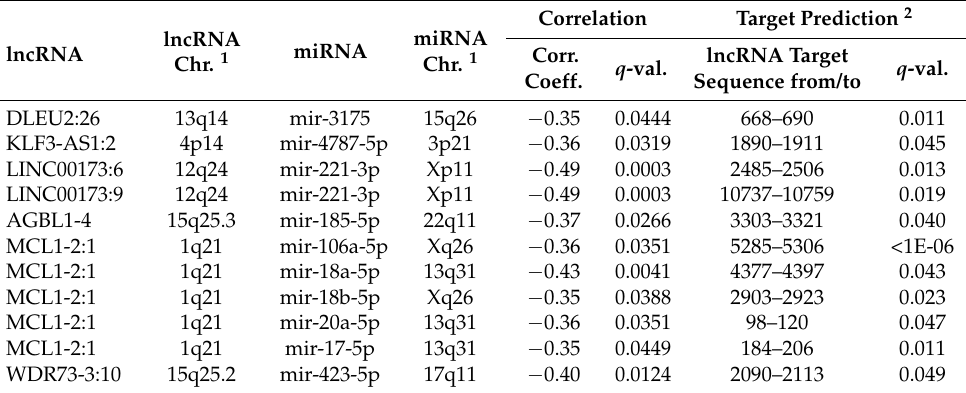
Table 1. Target prediction metrics of correlated lncRNA–miRNAs